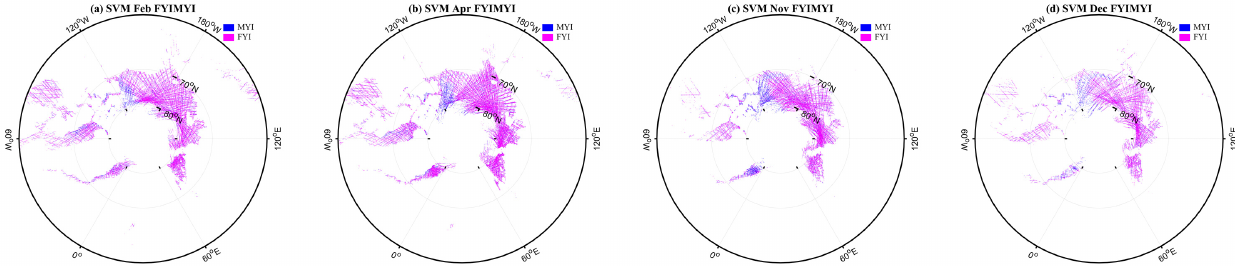
Figure A17. SVM for FYI-MYI classification using the data in March as the training set. The data in ( a ) February, ( b ) April, ( c ) November, and ( d ) December are used as the test set in turn.